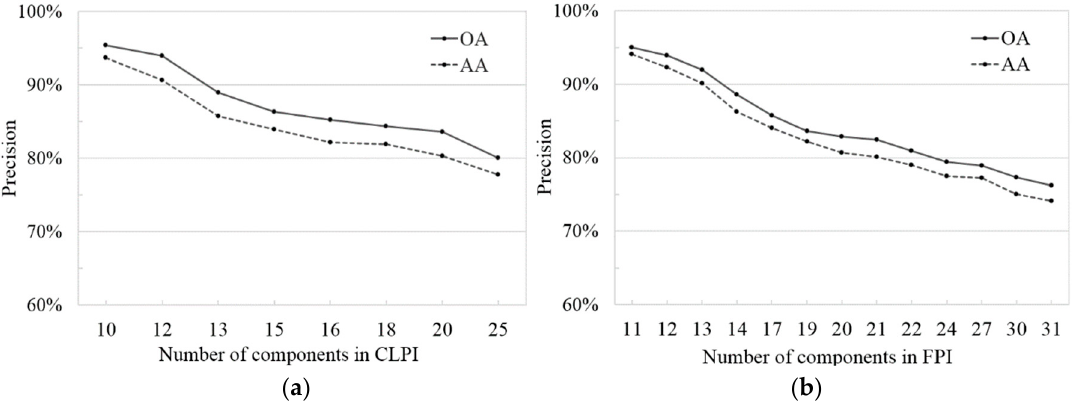
Figure 7. The relation between the number of structural components and the detection accuracy: ( a ) In the column layout plan image; ( b ) In the framing plan image.